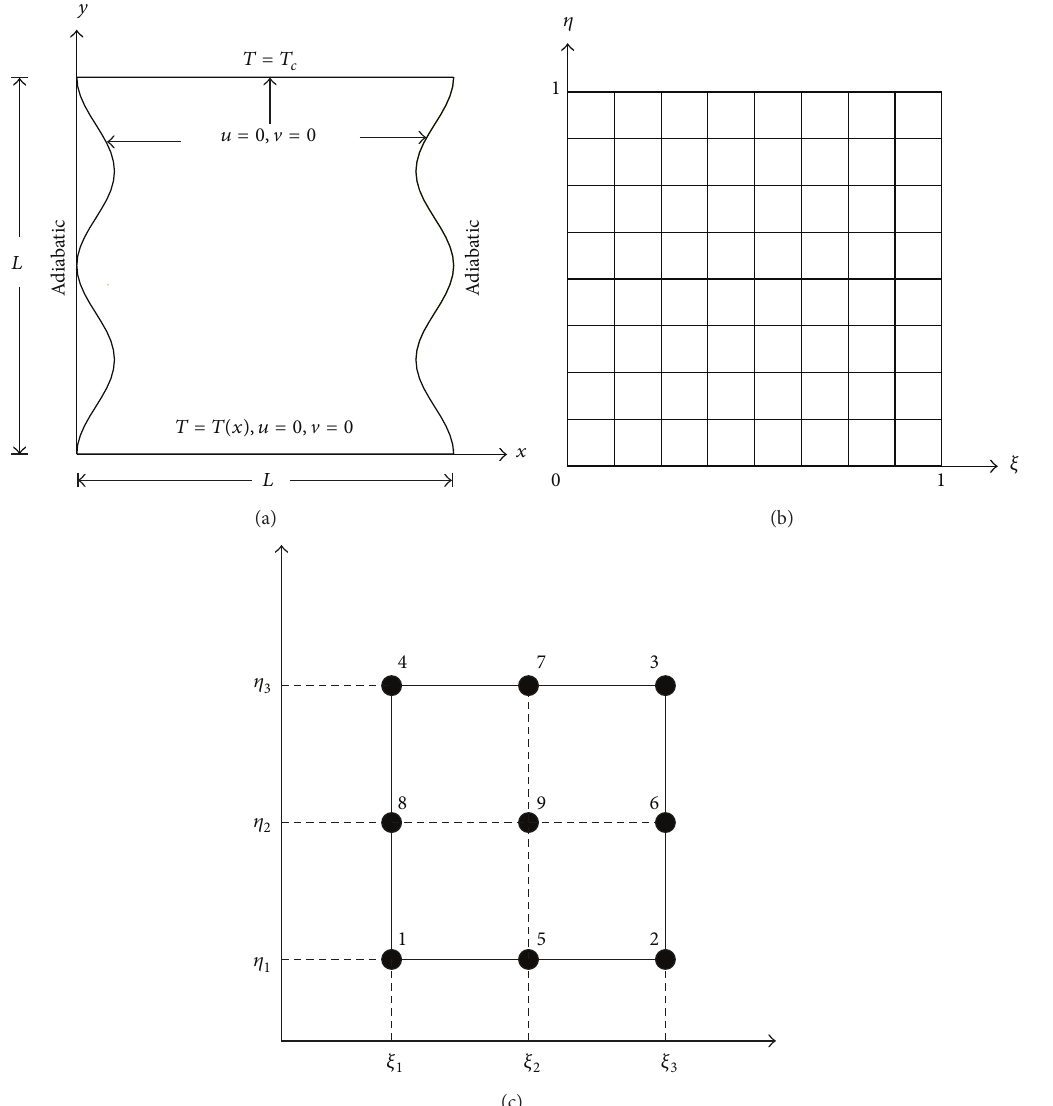
Figure 1: (a) Physical model and boundary conditions of wavy enclosure, (b) a unit square in 𝜉𝜂 -coordinate, and (c) node numbering for biquadratic